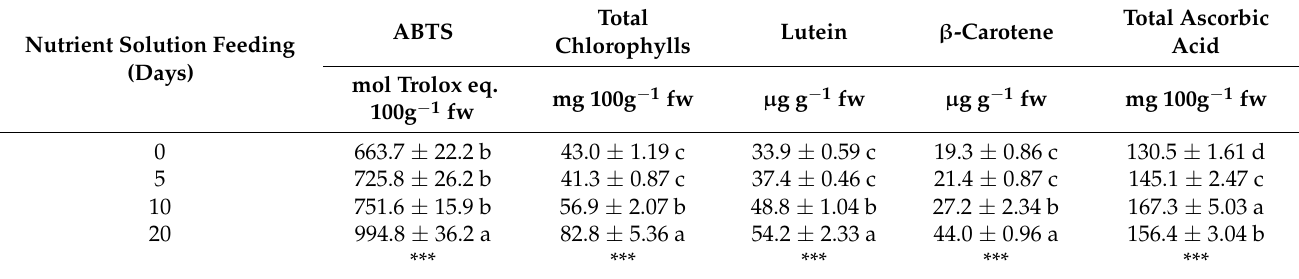
Table 3. Antioxidant activity, pigments, and total ascorbic acid content in relation to nutrient solution feeding regime (means ± SD).